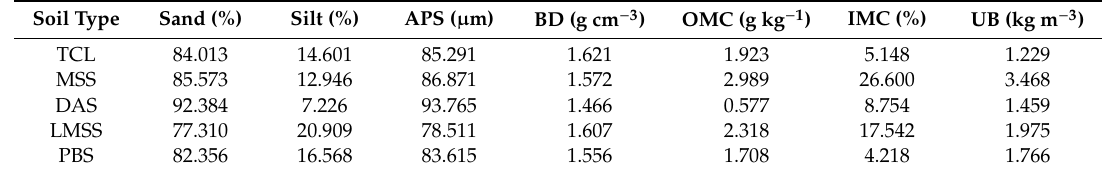
Figure 1. ( a ) Location of the study catchment within Inner Mongolia, China; and ( b ) soil types of the study catchment as well as the sampling sites used in this study. Table 1. Variation of soil parameters relative to soil type in Xilin River Basin from 0–50 cm.